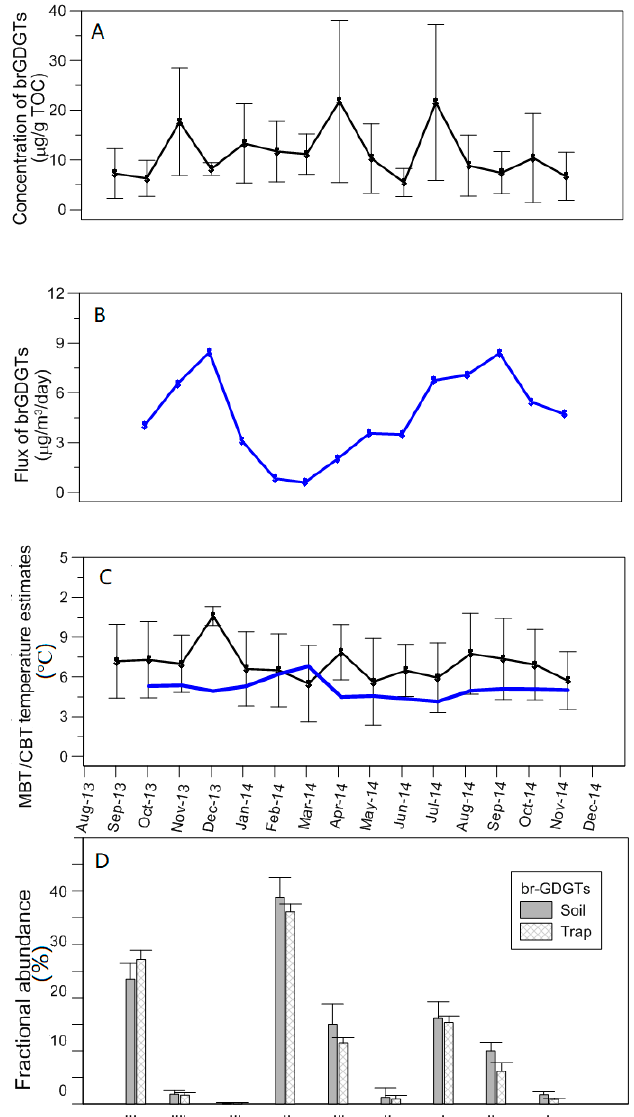
Figure 6. ( A ) Concentration of soil brGDGTs, ( B ) brGDGT flux of particles in the sediment trap at 20 m water depth, ( C ) brGDGT-based temperature estimates using the MBT / CBT (methylation / cyclisation) proxy in soils (black line, average from three soils in the catchment around the lake) and particles from the sediment trap (blue line). ( D ) Fractional abundance of brGDGT distribution in soils and sediment traps. Redrawn and modified from [21].